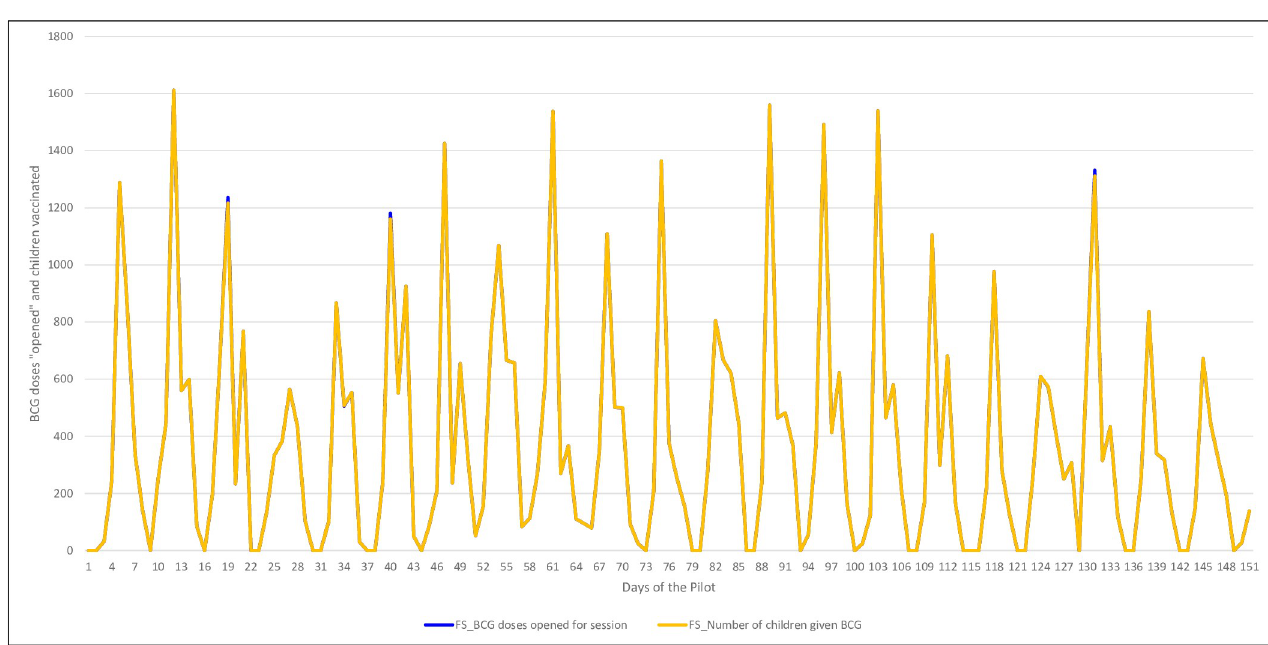
Fig 5. Number of children vaccinated with BCG vs. number of BCG doses opened during fixed-post vaccination sessions, during the 151 days of the pilot.